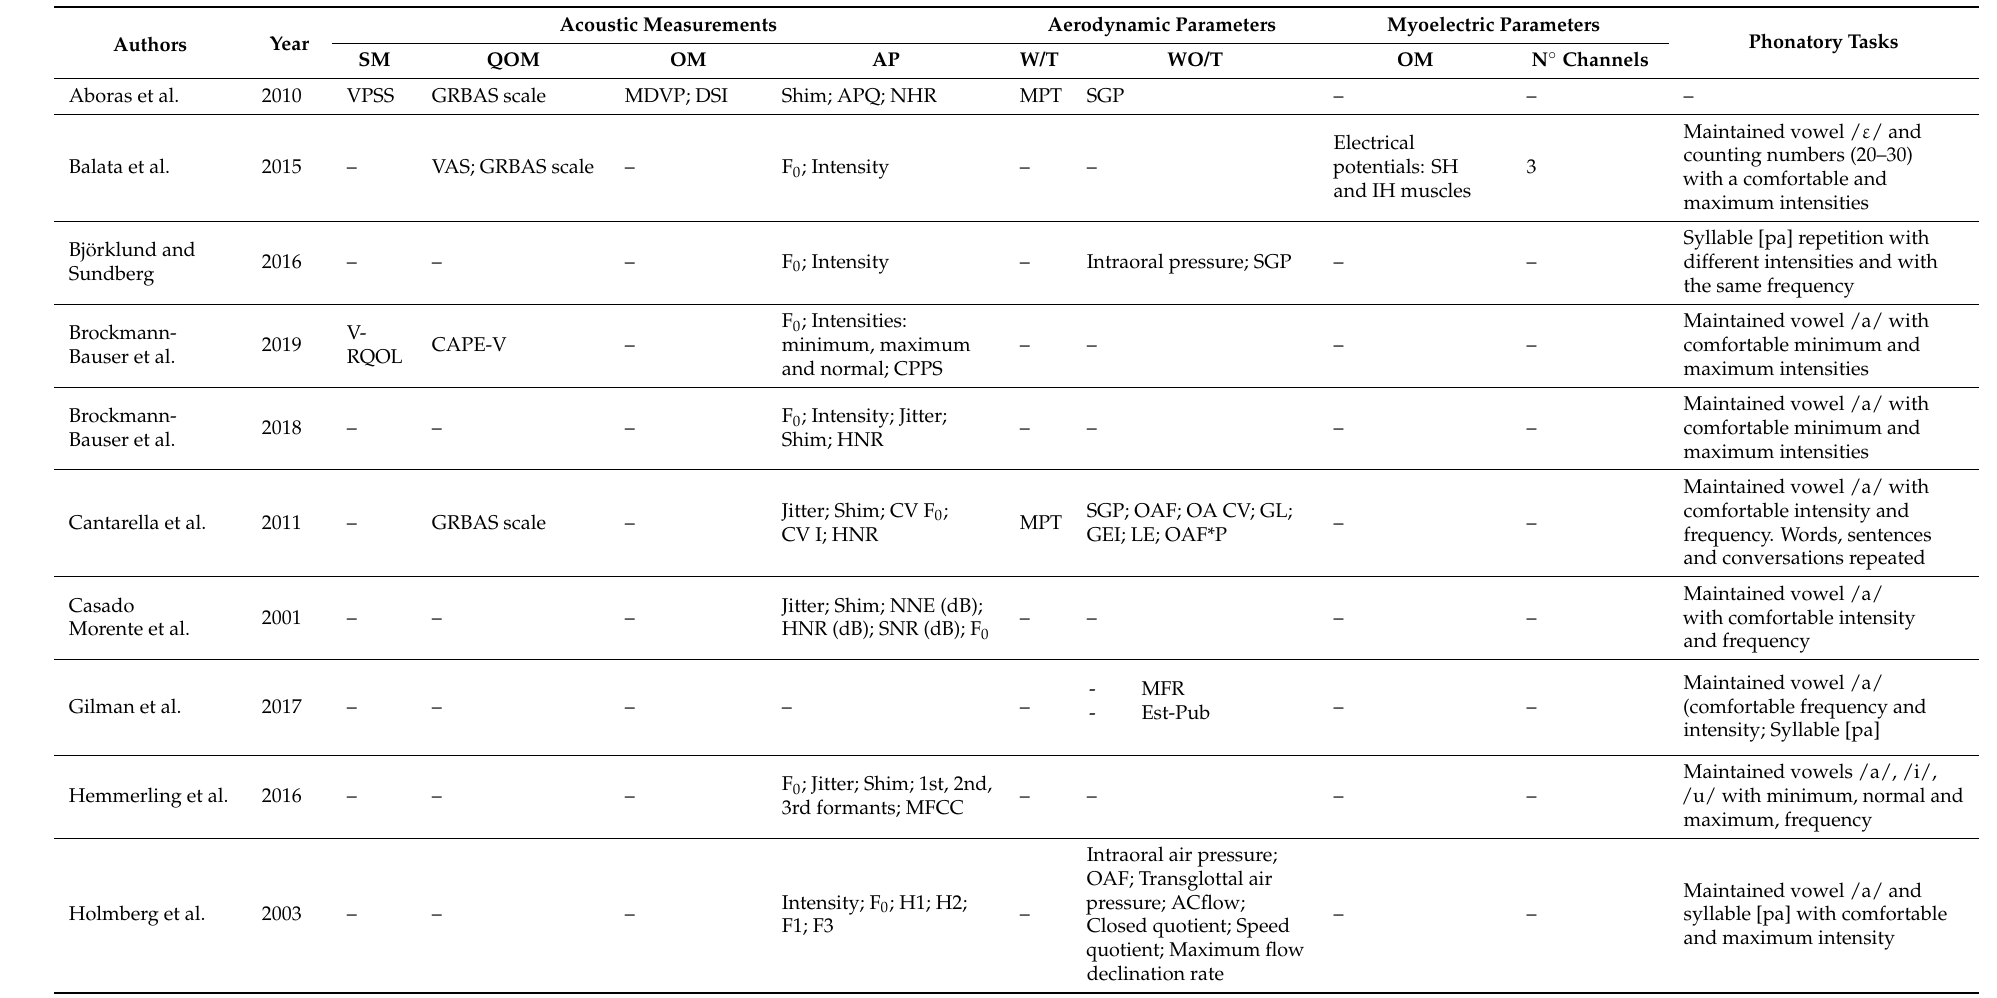
Table 2. Summary of the acoustic parameters analyzed in the selected